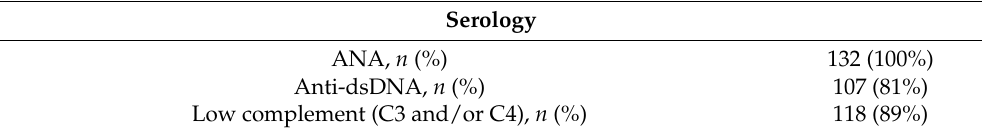
Disease duration at the time of study inclusion, months, median